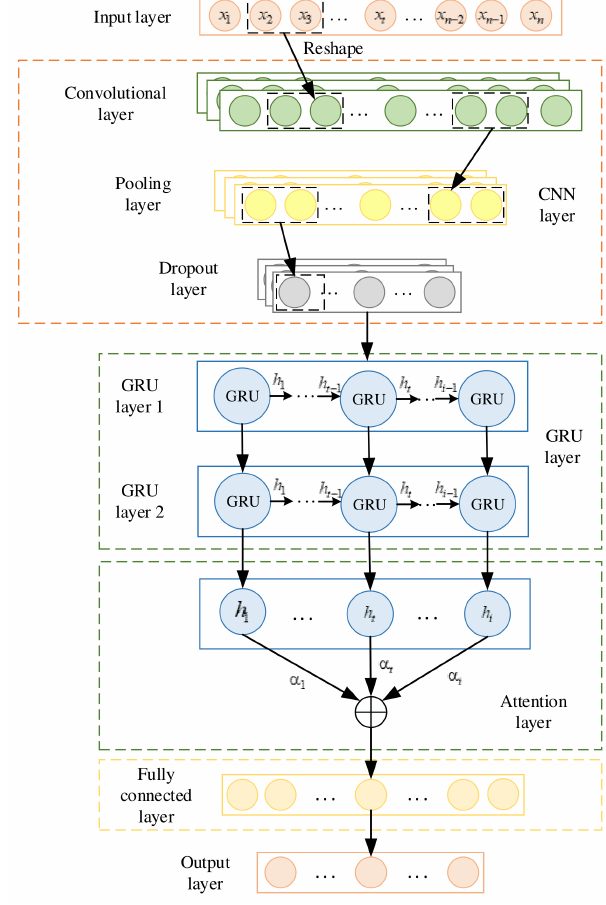
Figure 2. Structure of CNN-GRU model based on attention